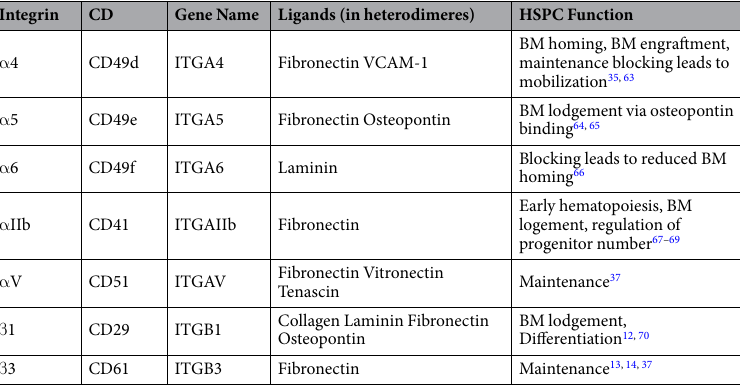
Table 1. Integrins described as HSPC